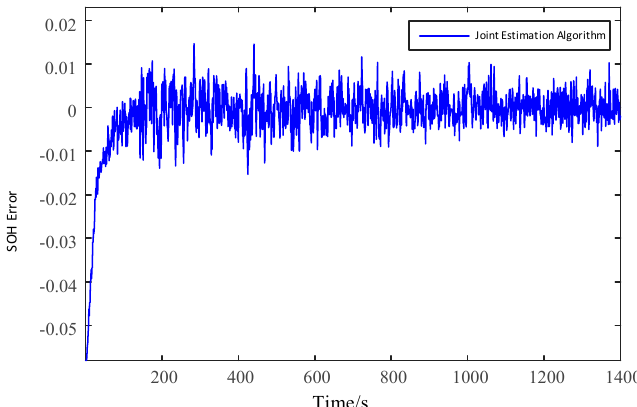
Figure 14. State of health (SOH) estimation curve of UDDS driving cycles based on the joint estimation algorithm.